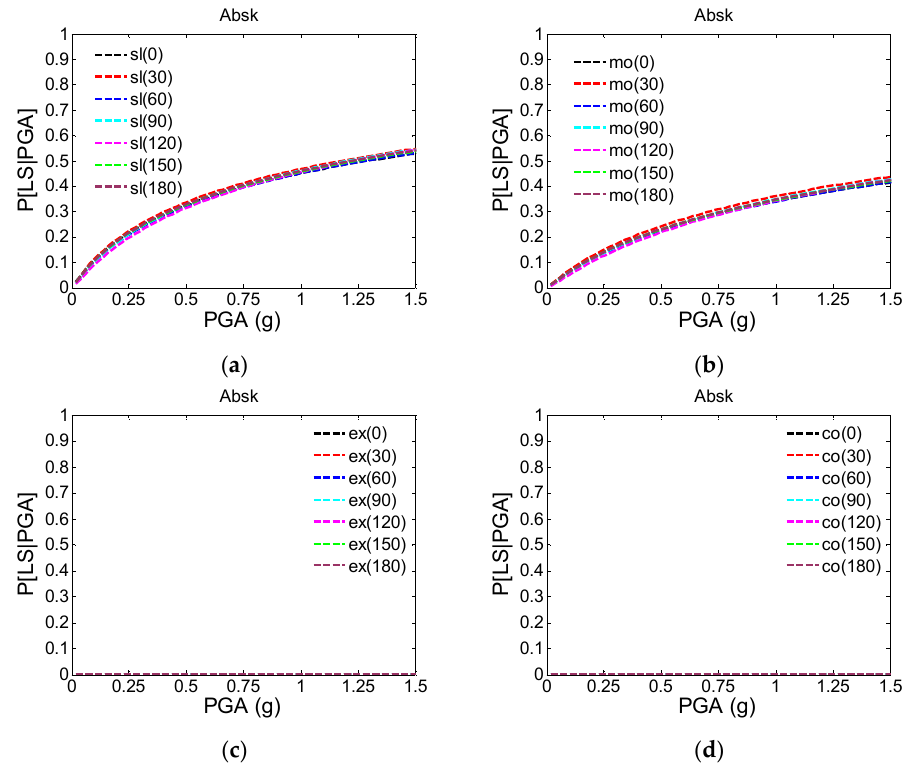
Figure 12. Seismic fragility curves of Absk subjected to different excitation angles in the ( a ) slight; ( b ) moderate; ( c ) extensive; and ( d ) complete limit states.